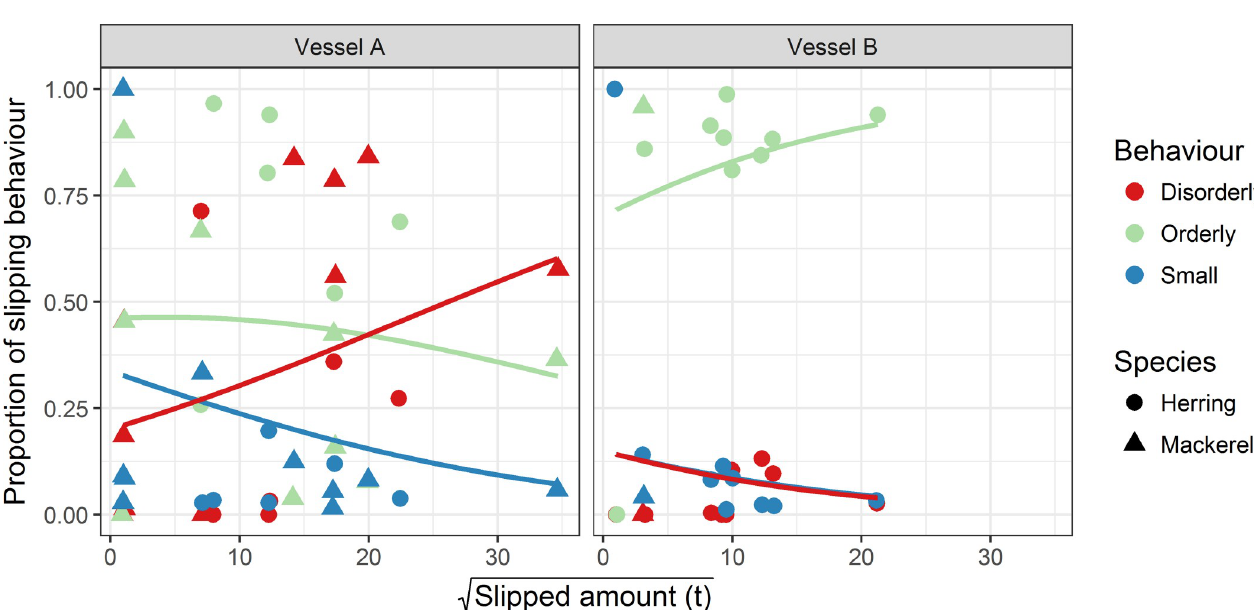
Fig 7. Behavioural composition as a function of slipped amount. The relationship between slipped amount and the composition of slipping behaviour (comprised of the behavioural units of disorderly, orderly and small) for herring and mackerel released by two different purse seine vessels. For Vessel B, note that the regression lines for “Disorderly” and “Small”